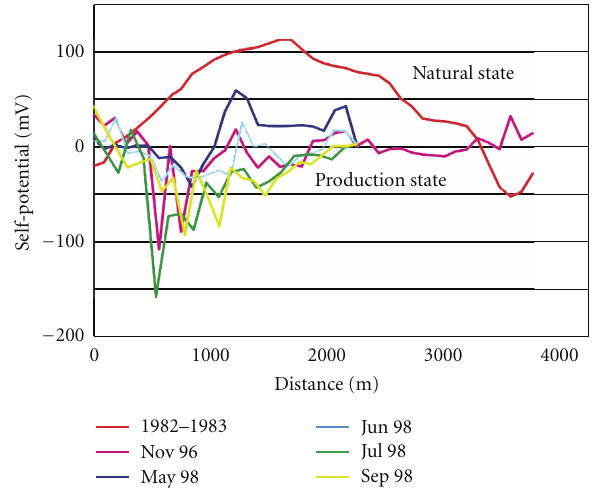
Figure 10: SP profile along a survey line passing through the central part of the Okuaizu geothermal field in Japan. The red line shows the SP profile under natural state conditions, measured in 1982-83. The survey in November 1996 was carried out about 1.5 years after start-up of the Yanaizu-Nishiyama power station. The repeated surveys in 1998 were carried out after 2 months shut-in of production wells in April and May 1998, after [171,